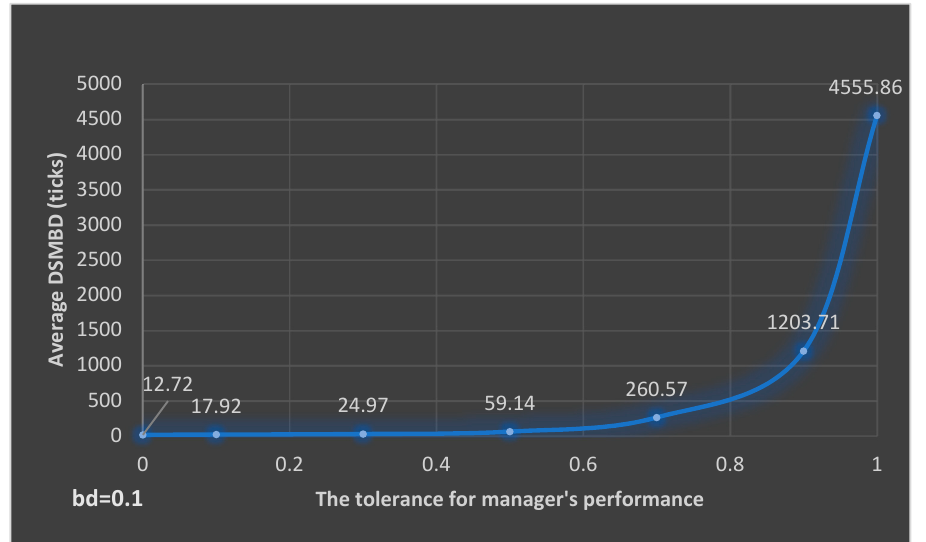
The tolerance for manager's performance bd=0.1